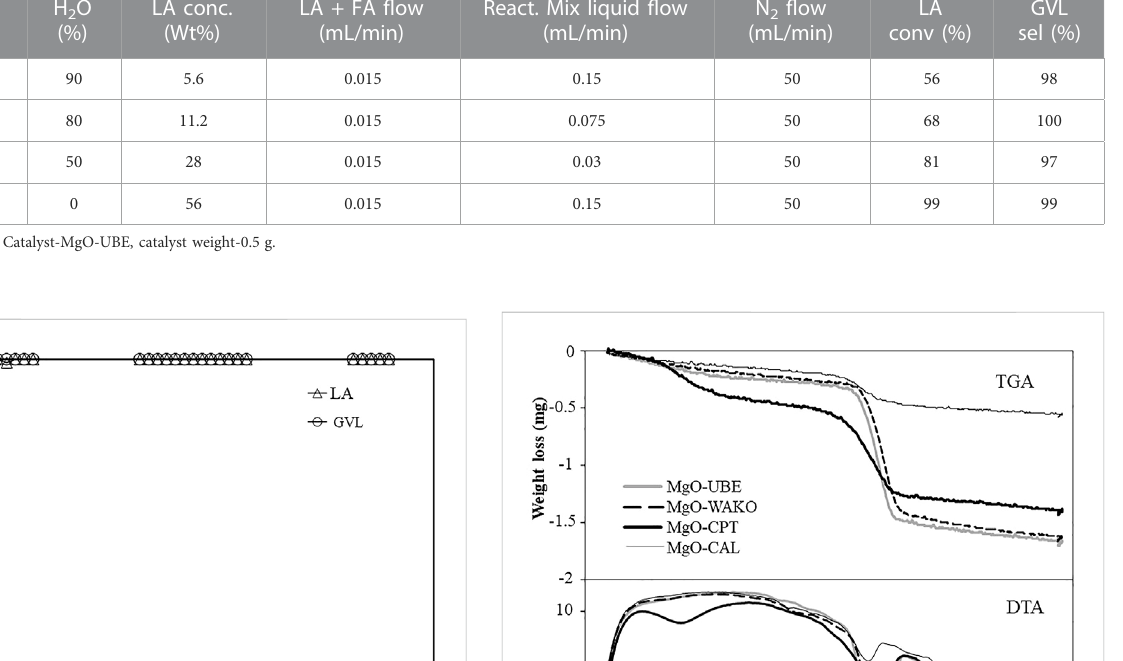
TABLE 4 Effect of variation of LA and H 2 O concentration on conversion selectivity. Sol. Conc. (Wt%)